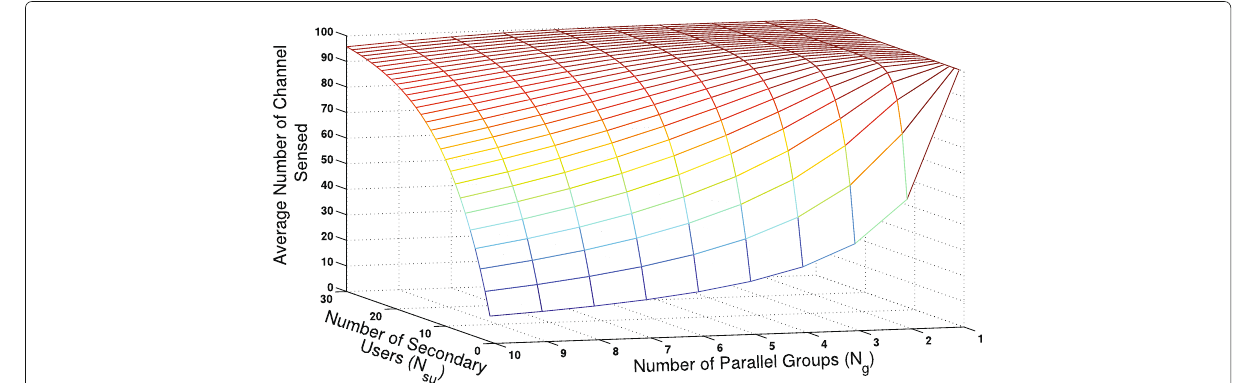
Fig. 4 Average number of channel sensed in parallel sensing scheme by the SUs